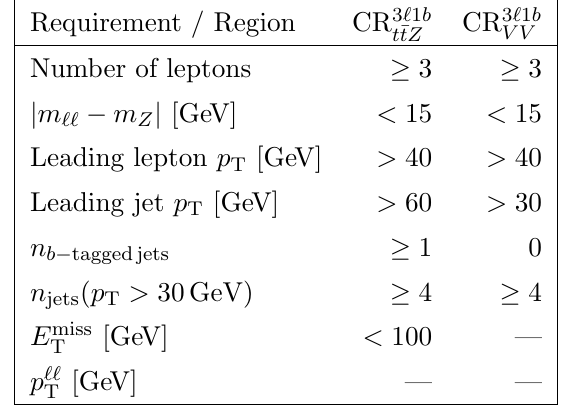
Table 4. De(cid:12)nition of the control regions used in the 3 ‘ 1 b selection.